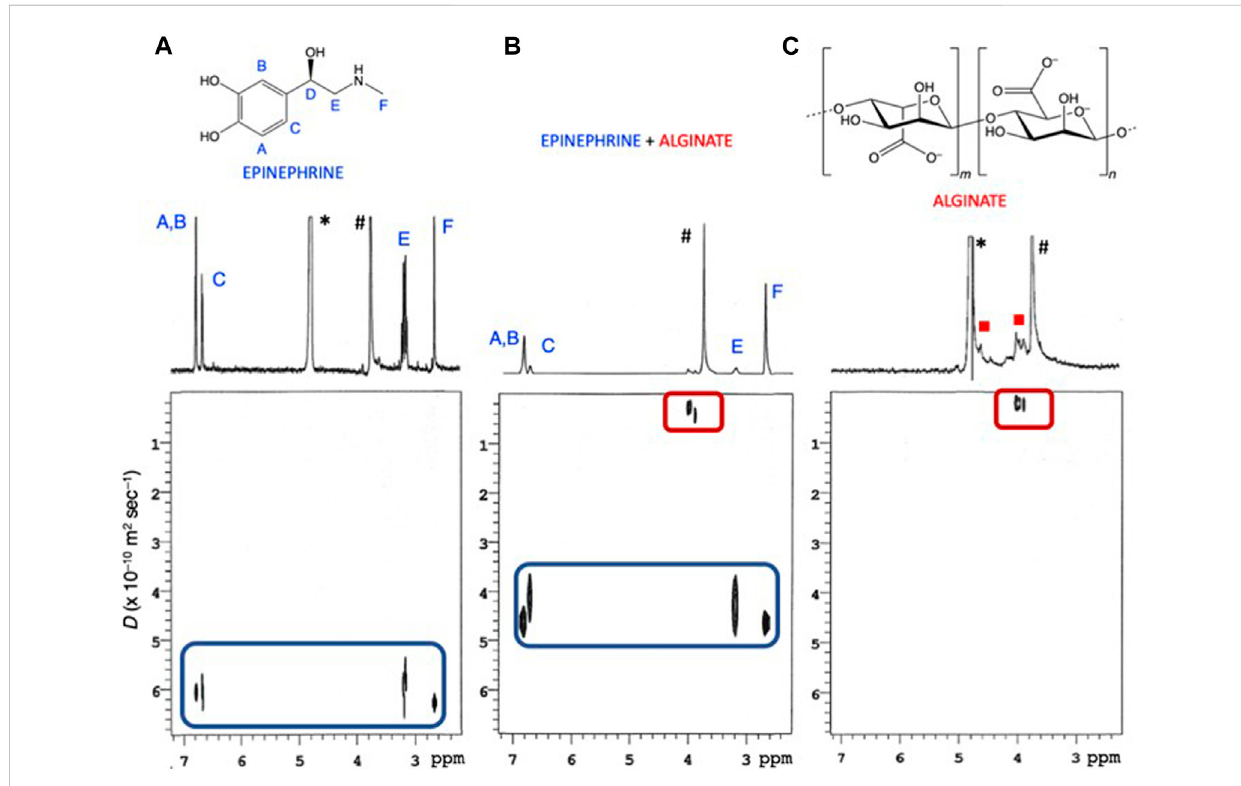
FIGURE 8 DOSY plots (500 MHz, T = 298.15 K, D 2 O) recorded on solutions containing: (A) c Eph- = 2.29 mmol dm − 3 ; (B) c Eph- = 2.29 mmol dm − 3 and c Alg 2 - = 2.60 mmol dm − 3 ; (C) c Alg 2 - = 2.52 mmol dm − 3 * Residual HOD solvent peak; # 1,4-dioxane internal